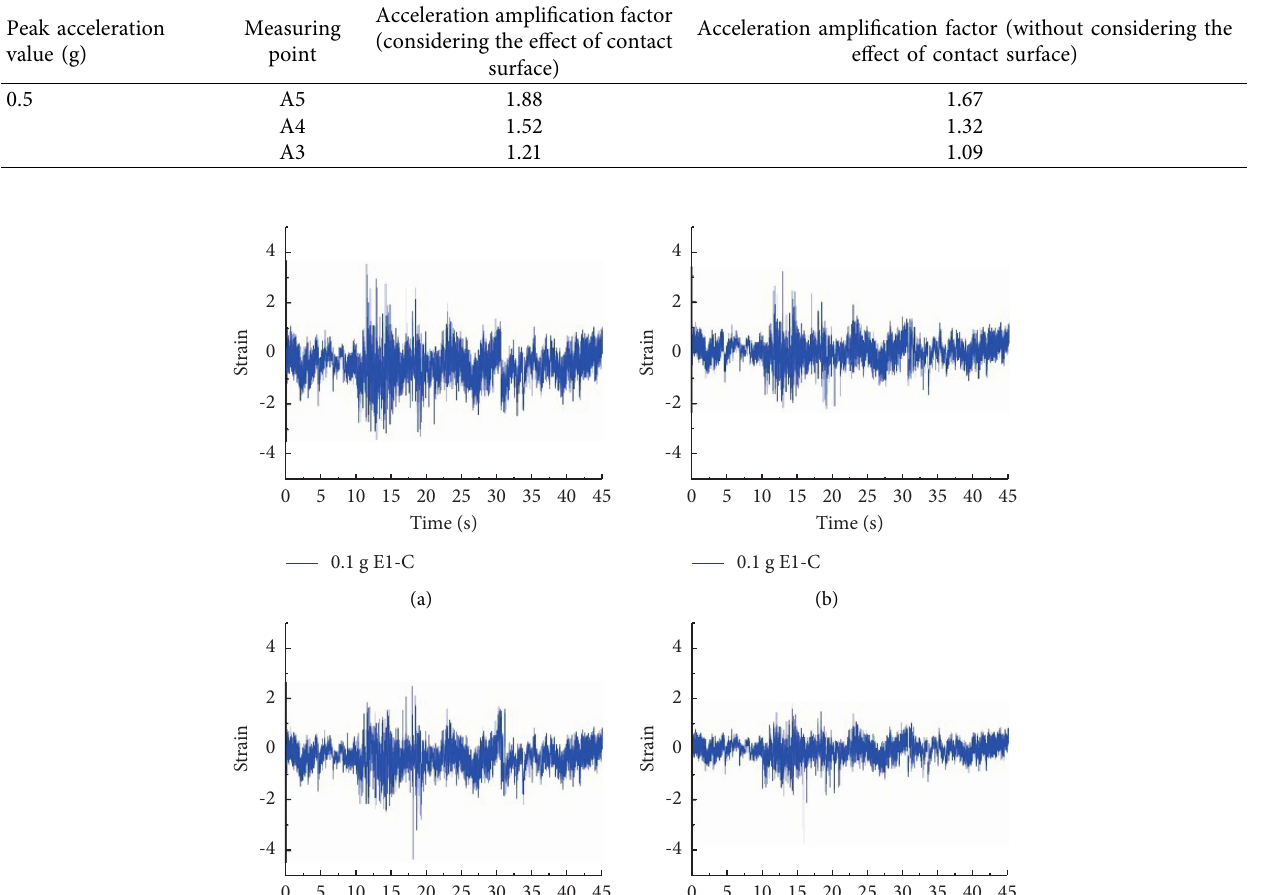
Table 4: Acceleration amplification factor of pipe sidewall.